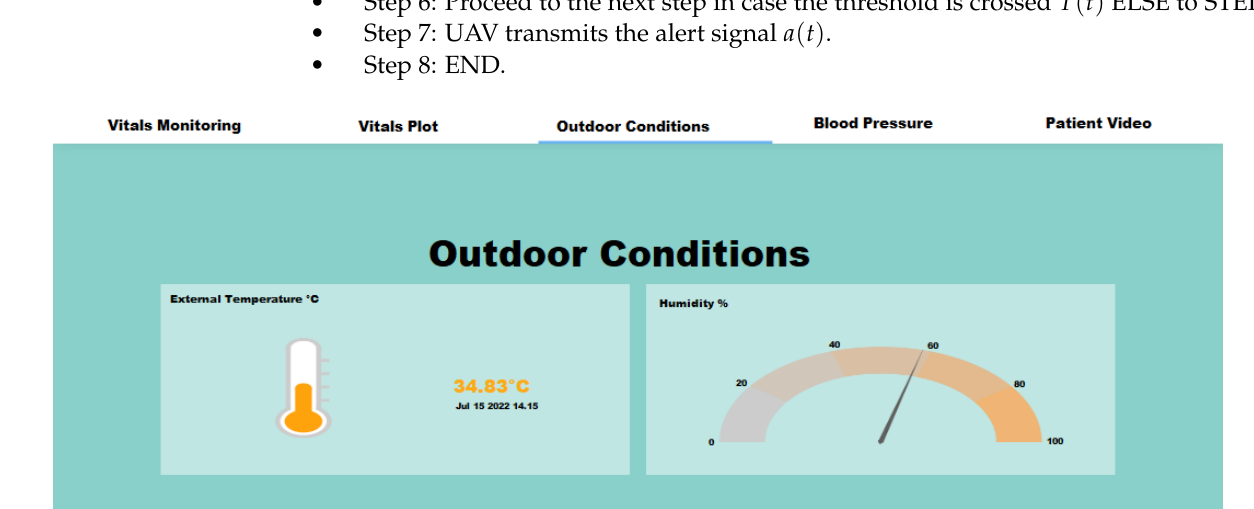
Figure 10. Patient’s surrounding weather conditions displayed on the website.